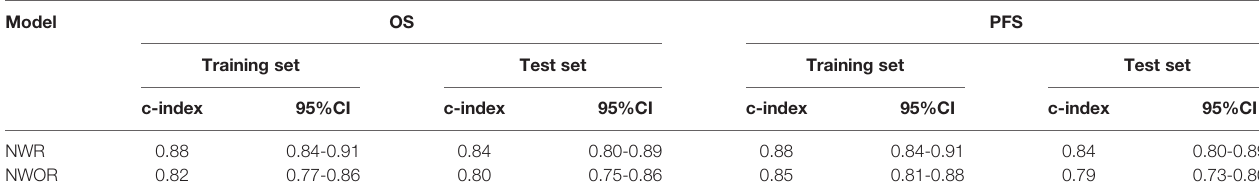
TABLE 5 | Diagnostic Performance of the NWR and NWOR.